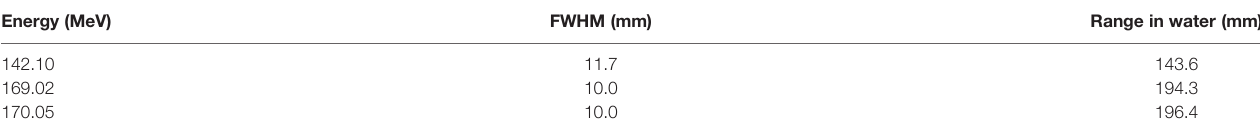
TABLE 3 | Primary beam energy, FWHM at the isocenter, and range in water (calculated with LISE++) of the proton beams used for the measurements. Energy (MeV)